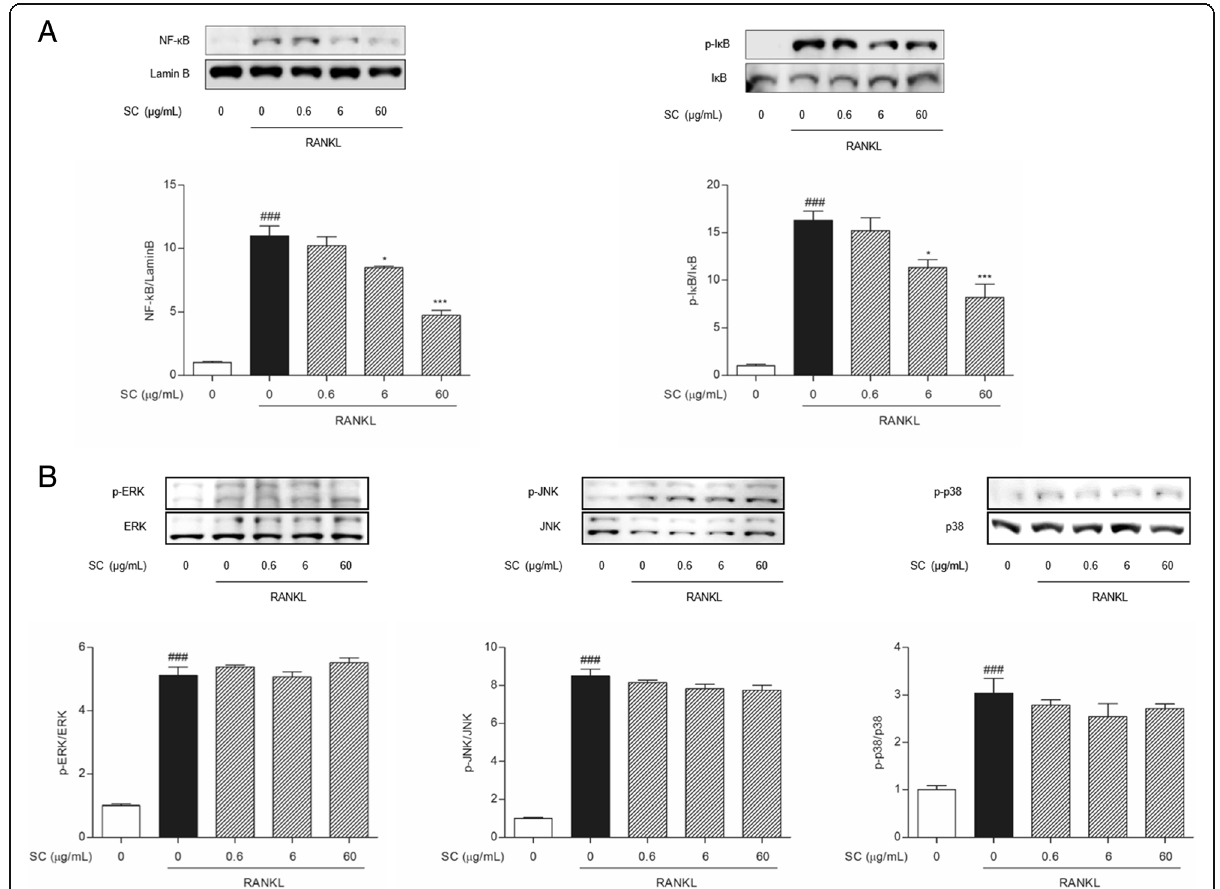
Fig. 4 The effects of SC on ( a ) NF- κ B and I κ B- α , and ( b ) MAPKs pathway-related protein expressions in RANKL-stimulated RAW 264.7 cells. RAW 264.7 cells were cultured in the presence of RANKL with the vehicle or SC. After 7 days, total protein was then isolated and protein expression levels were evaluated by Western blot assay. Data are represented as the means ± S.E.M. of three independent experiments. ### p < 0.001 compared with non-treated cells. * p < 0.05 and *** p < 0.001 compared with only RANKL-treated